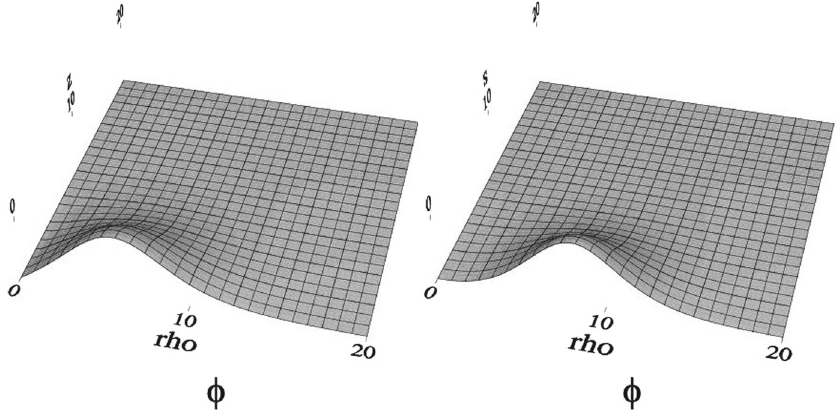
Fig. 7 The scalar field in cylindrical coordinates φ(ρ, z ) for two rotating boson-star solutions: (left) k = 1 and (right) k = 2. The two solutions have roughly comparable amplitudes in scalar field. Note the toroidal shape. Reprinted with permission from Lai